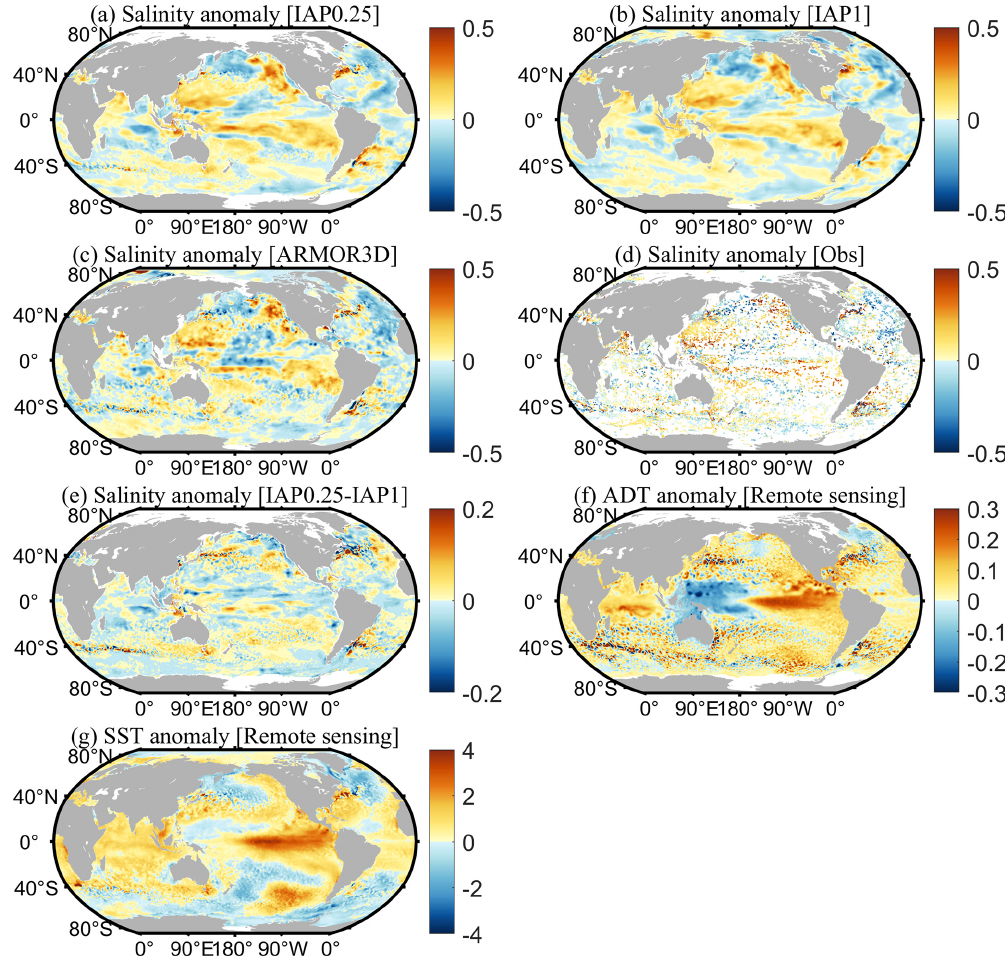
Figure 3. Spatial distribution of salinity anomalies of (a) IAP0.25 ◦ , (b) IAP1 ◦ , (c) ARMOR3D, (d) in situ observations, and (e) IAP0.25 ◦ minus IAP1 ◦ at 100m, as well as the spatial distribution of (f) ADTA and (g) SSTA in January 2016.